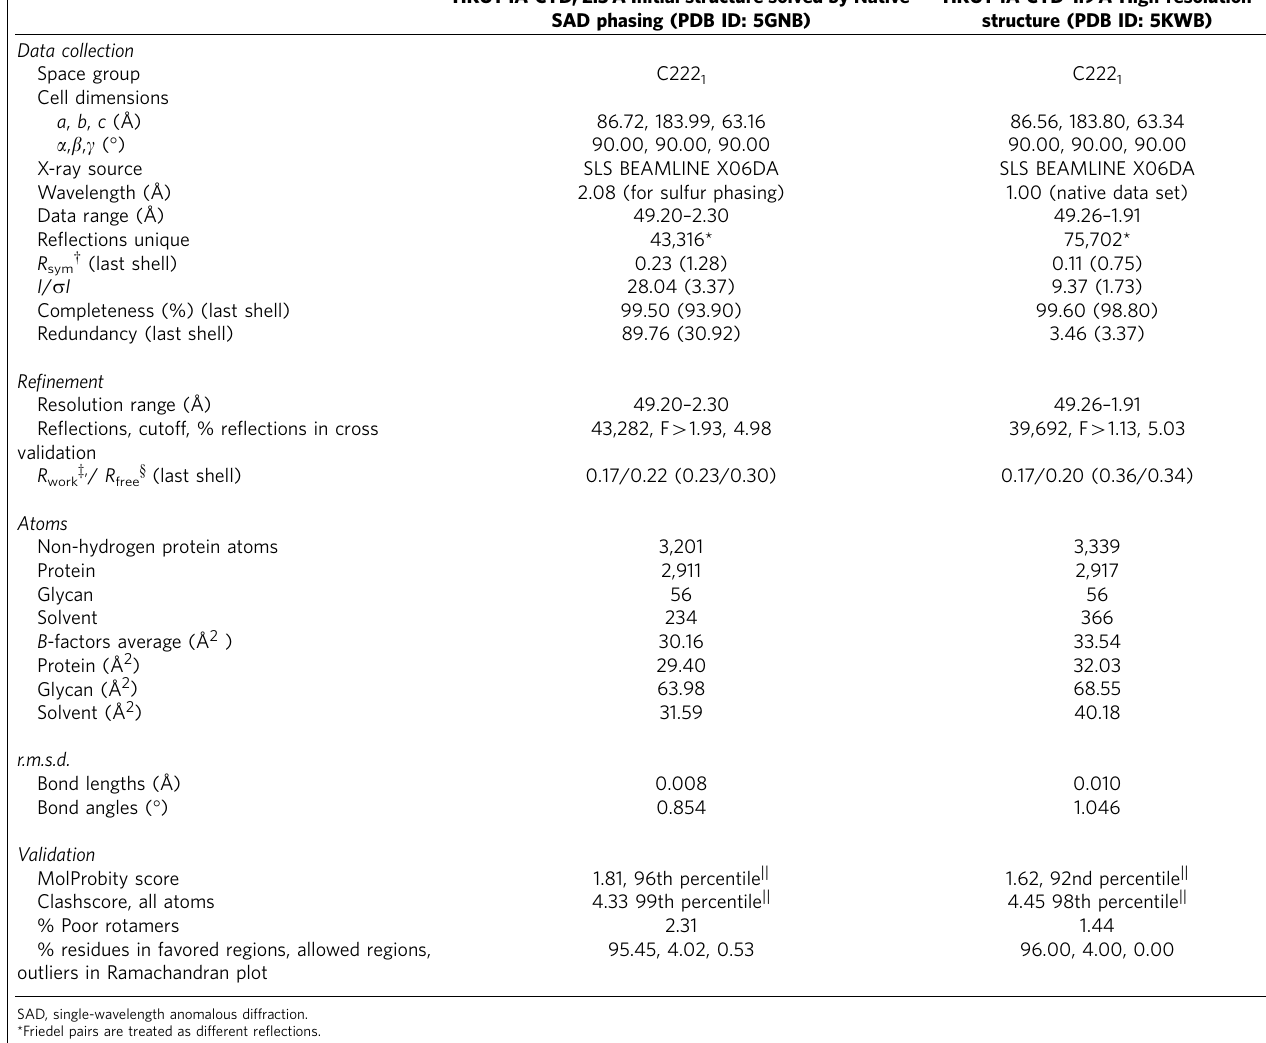
SAD, single-wavelength anomalous diffraction. *Friedel pairs are treated as different reflections. w R sym ¼ P hkl P j |I hkl,j - I hkl |/ P hkl P j I hkl,j , where I hkl is the average of symmetry-related observations of a unique reflection. z